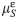
Changes in perception questions resulting from update of the somatosensory characterization of the perturbed vowel P(SΦ | [Φ = /ɛ/]).The update corresponds to a shift of the mean value μSɛ in the direction of phoneme /i/, as would result from compensation to an auditory perturbation towards /a/ (horizontal arrow). The outcome of simulations before update (solid lines) are superimposed to those after update (dashed lines).